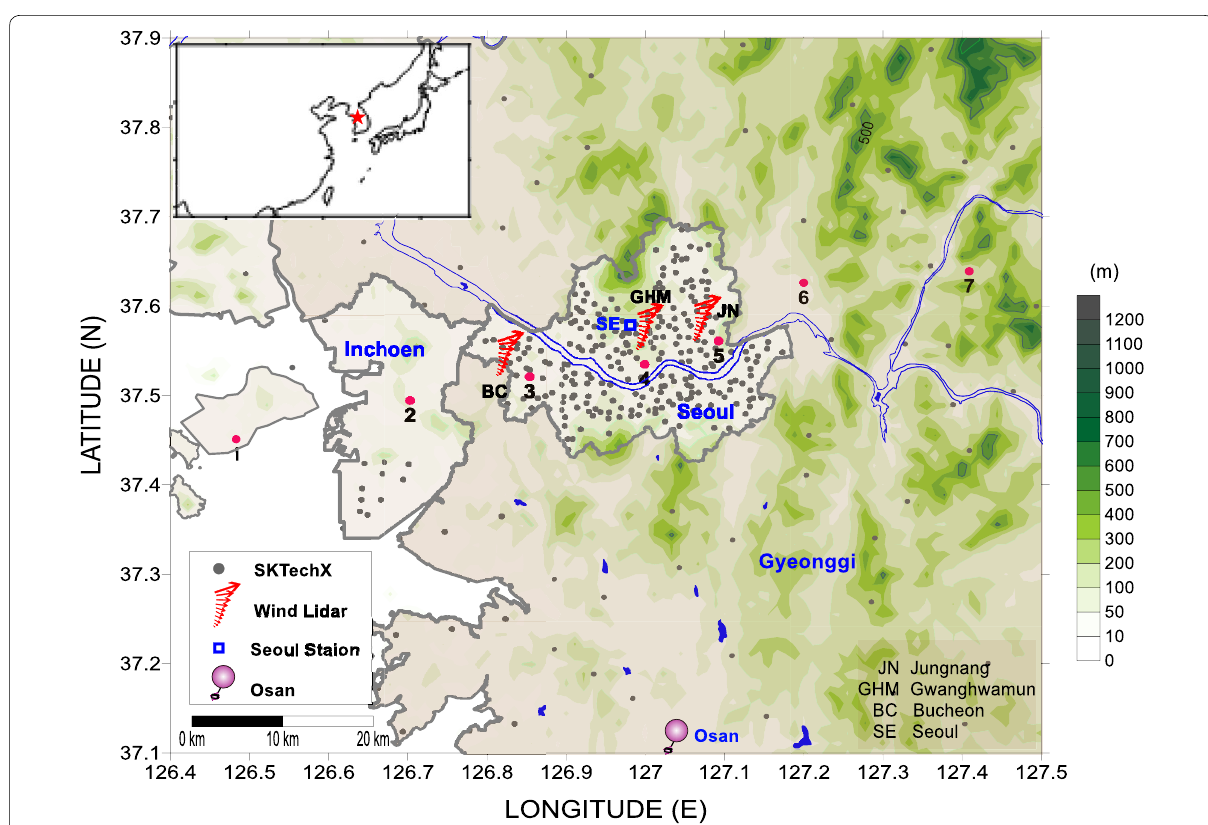
Fig. 1 Location of the SKTechX surface meteorological observation stations, wind lidar stations, Seoul automatic synoptic observation station, and Osan upper‑air station in the Seoul Metropolitan Area. Selected SKTechX stations are indicated by the red‑filled circle with the